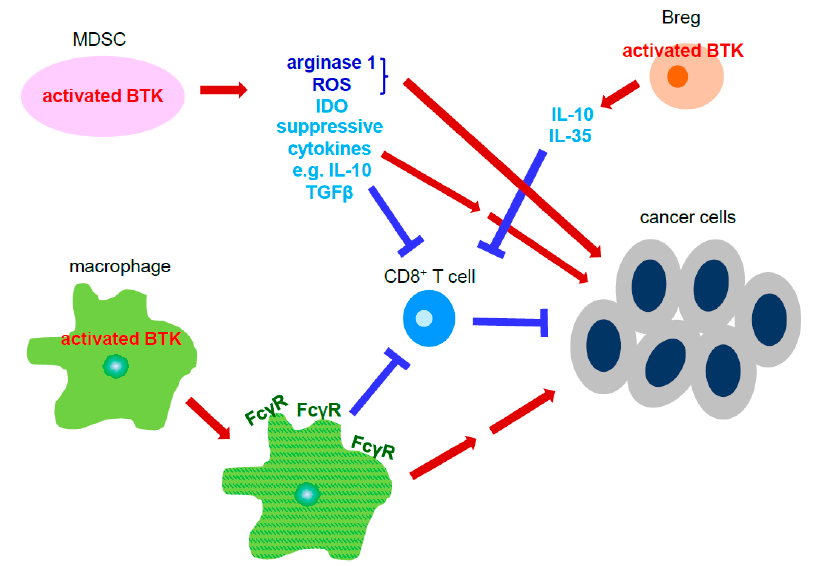
Figure 3. Activated BTK signaling of the stromal cells promotes cancer cell growth and progression. Activated BTK in myeloid-derived suppressor cells increases several molecules, including arginase-1, ROS, IDO, and suppressive cytokines, which directly and indirectly potentiate growth and development of cancer cells. Activated BTK in macrophages induces Fc γ R expression. Fc γ R + macrophages can directly promote cancer cell proliferation and metastasis or through inhibition of cytotoxic CD8 + T cells, which eliminate cancer cells. Activated BTK in the regulatory B cells is able to elevate cancer cell growth and progression by their secreted suppressive cytokines, including IL-10 and IL-35, that suppress cytotoxic CD8 + T cells. Abbreviation: MDSC: myeloid-derived suppressor cell; Breg: regulatory B cells; ROS: reactive oxygen species; IDO: Indoleamine 2, 3-dioxygenase; TGF β : transforming growth factor β ; Fc γ R: Fc γ receptor.